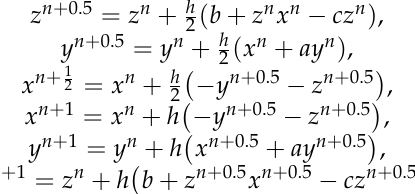
Table 2. Parameter values used in simulation of the Rössler system.